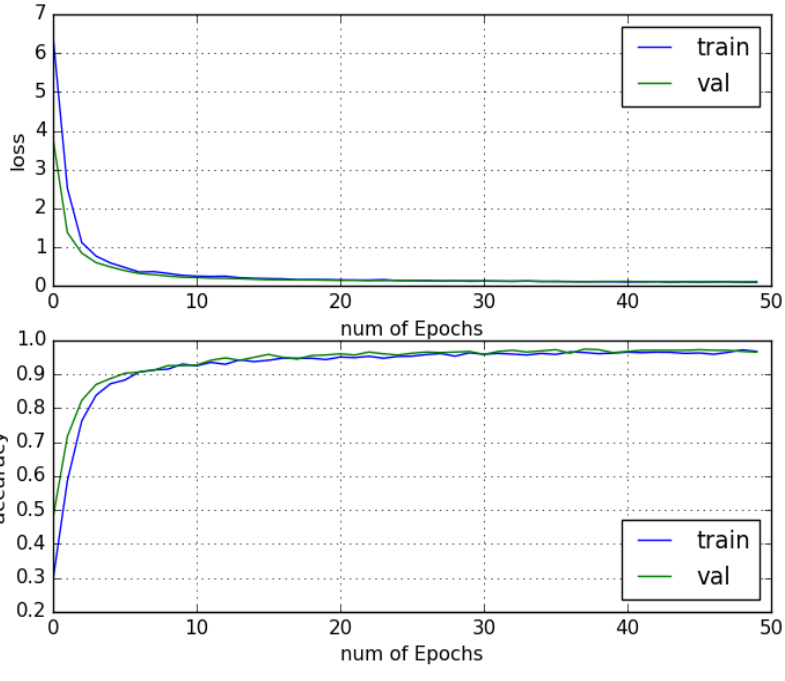
Figure 11. Fine tune DHCD model on Kaggle Devanagari numeral dataset using RMSprop